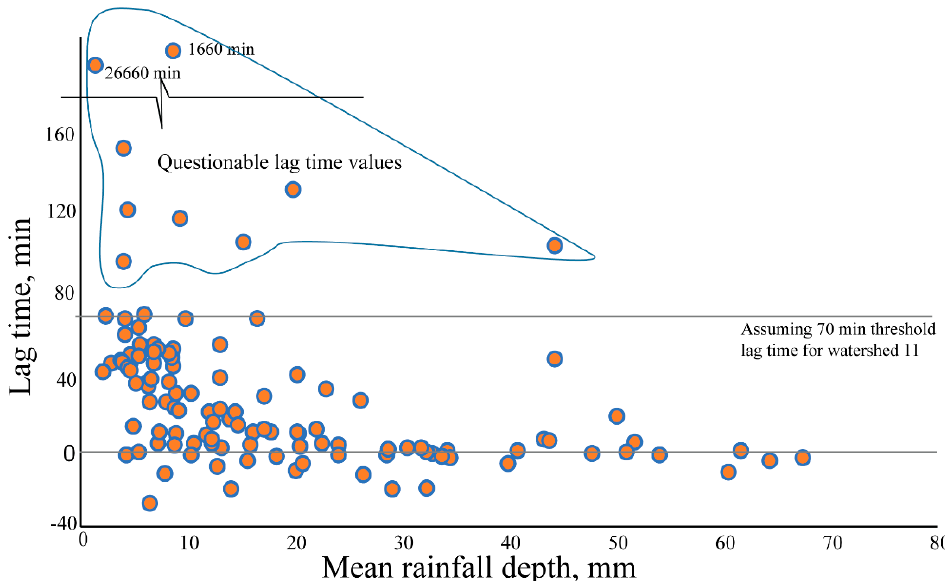
Figure 4. Example showing questionable events identified by lag time method and visual aid to determine the value of threshold lag time for WS-11. The suspicious events are those with outlier lag times. The threshold lag time for WS-11 based on the distribution of the computed lag time values is 70 min, where it showed clear separation from the rest of the calculated